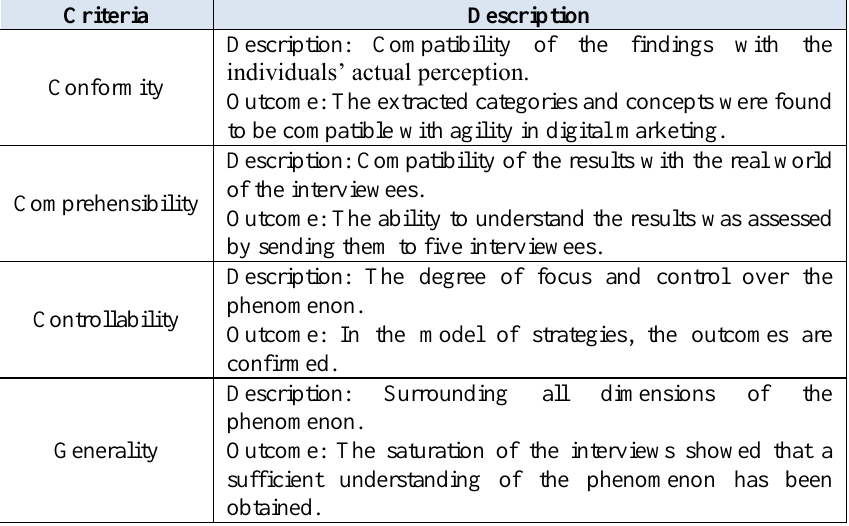
Table 3. Qualitative Validity Based on the Theory Derived from The